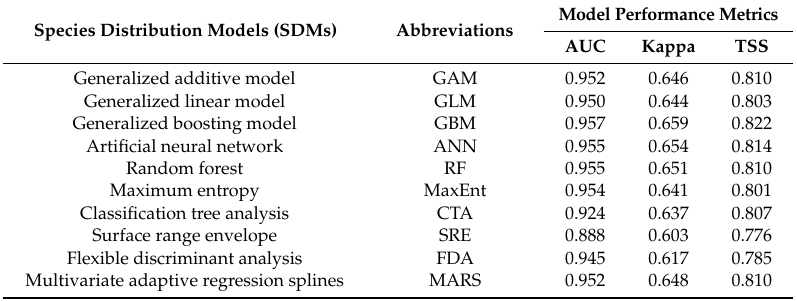
Table 2. List of single-algorithm species distribution models used for mapping potential squid habitat distribution with the respective performance metrics obtained during the model runs. Based on the true skill statistics (TSS), multi-model ensemble was developed using models with TSS ≥ 0.80. Model algorithms in bold were excluded in the final ensemble habitat model as their TSS values were below the cut-off.